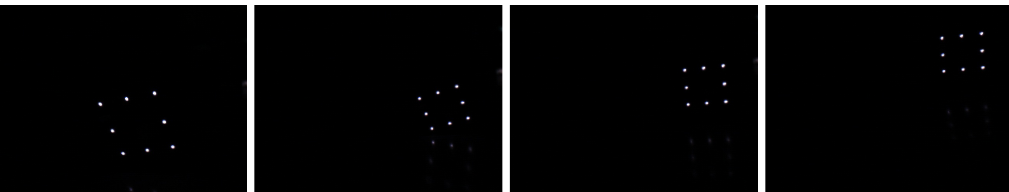
Figure 4. Infrared LED images during